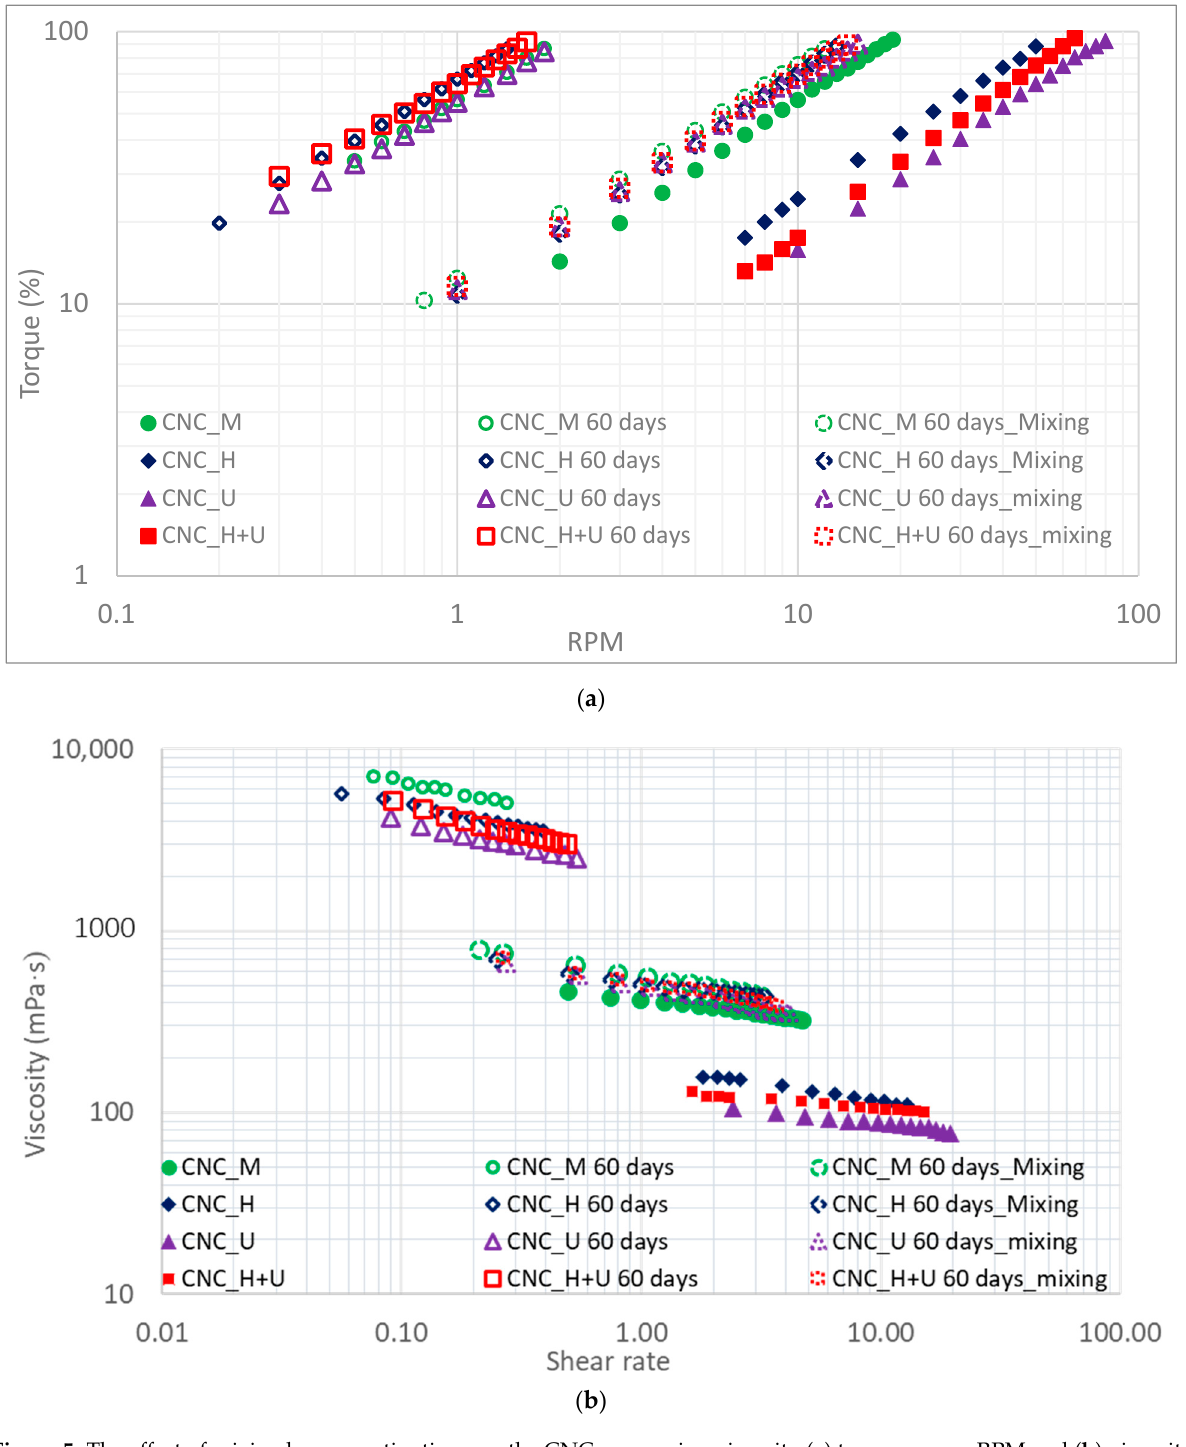
Figure 5. The effect of mixing by magnetic stirrer on the CNC suspension viscosity ( a ) torque versus RPM and ( b ) viscosity versus shear rate.